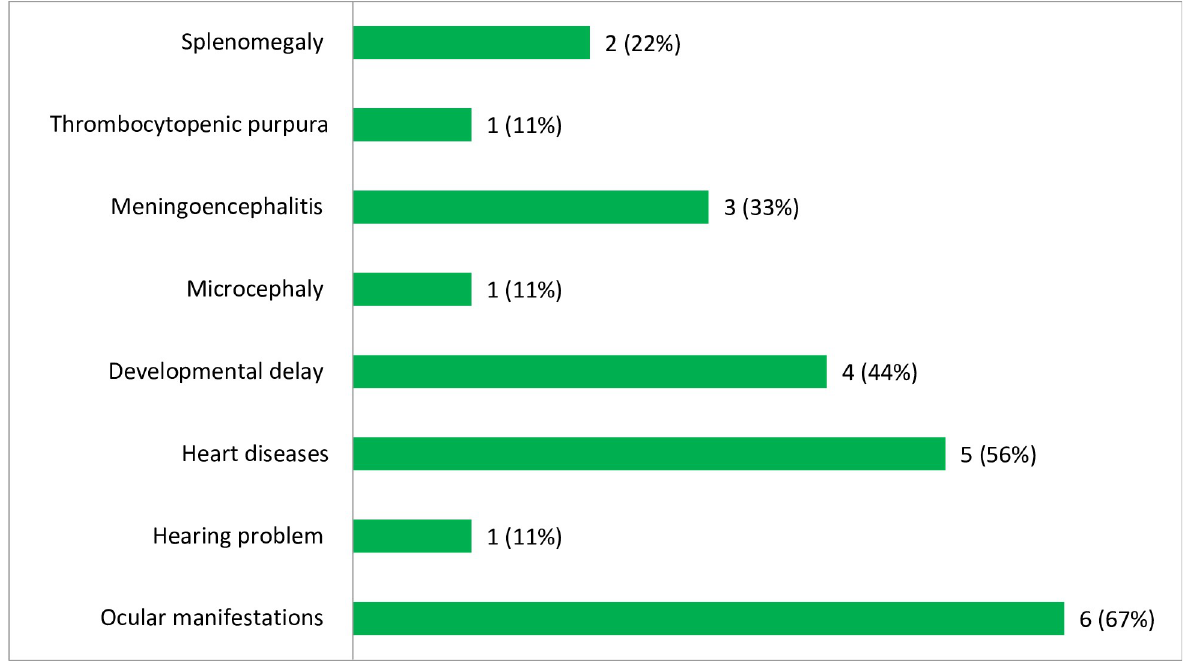
Fig 4. The frequency of different clinical manifestations among infants with laboratory confirmed CRS cases in Amhara Regional State Referral Hospitals, Northwest Ethiopia, December 2015-August 2017.